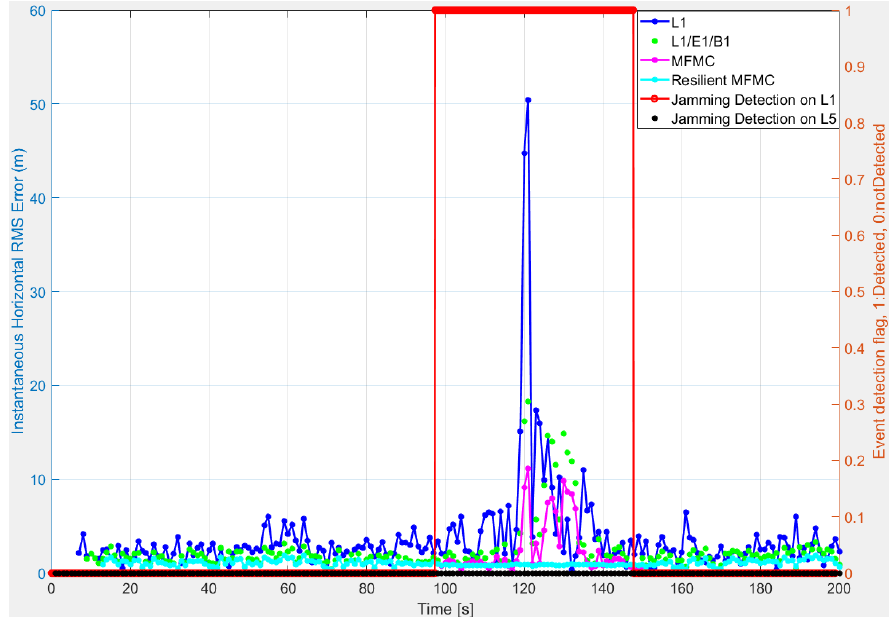
Figure 11. Instantaneous horizontal position error of different signal combinations along with jamming event detection for Scenario II.